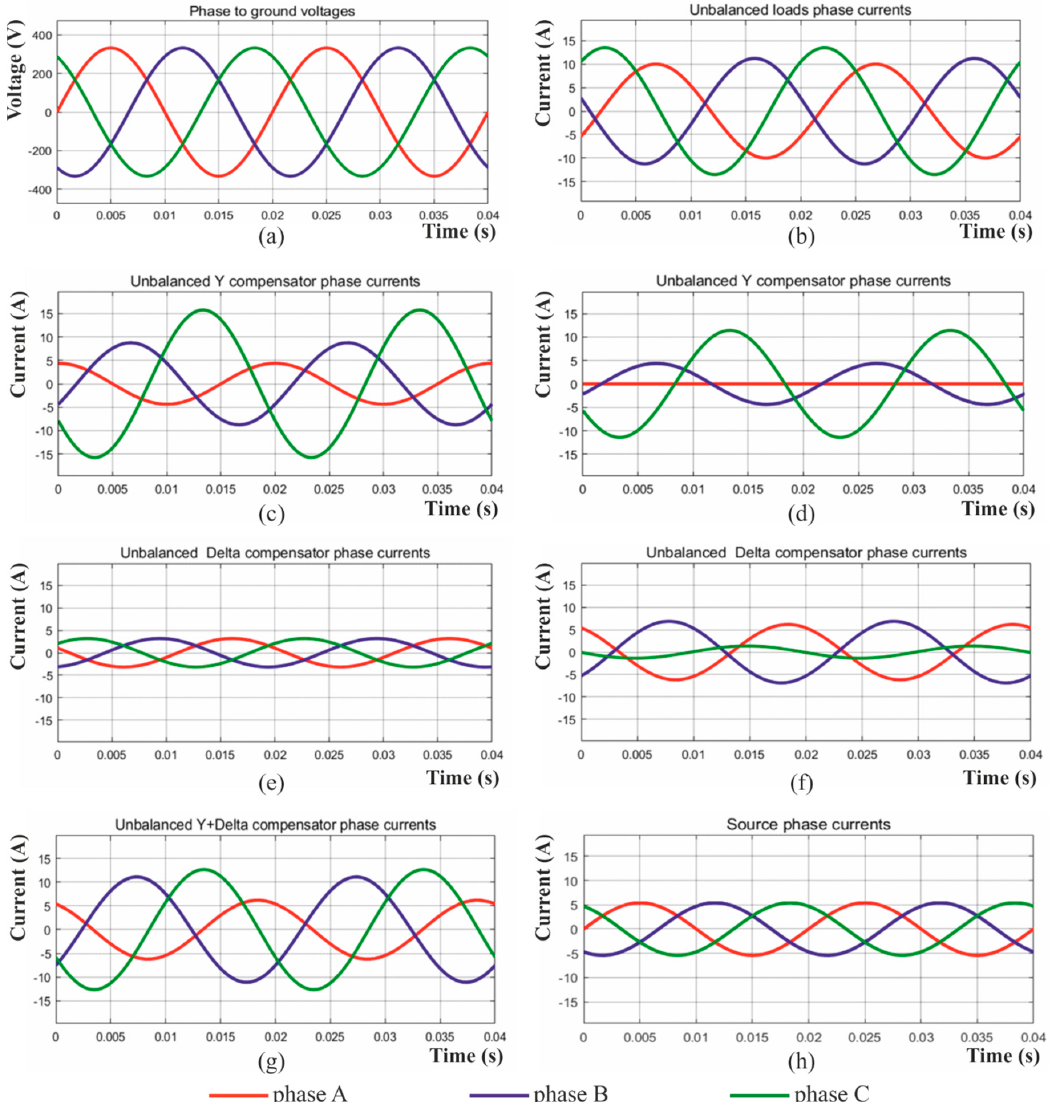
Figure 6. Voltages and currents waveforms in the sections of the load-compensator assembly: ( a ) phase to neutral voltages (BRC and BCC); ( b ) currents on the load phases (BRC and BCC); ( c ) currents on the Yn compensator phases (BRC); ( d ) currents on the Yn compensator phases (BCC); ( e ) currents on the ∆ compensator (BRC) phases; ( f ) currents on the ∆ compensator phases (BCC); ( g ) currents on the Yn + ∆ compensators phases (BRC and BCC); and ( h ) currents on the phases in PCC (BRC and BCC).